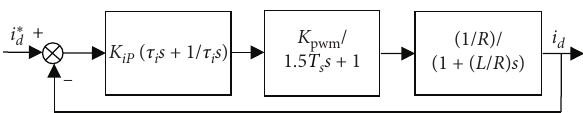
Figure 8: The simplified control diagram of inner current